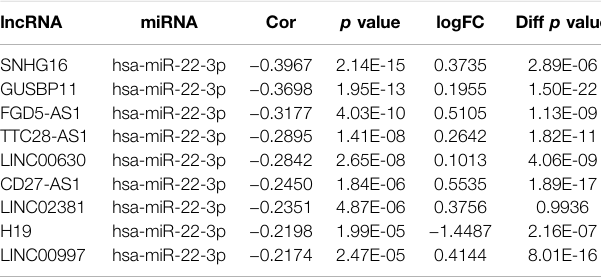
TABLE 3 | lncRNAs are signi fi cantly negatively correlated with miR-22-3p in LIHC and their expression in LIHC and control tissues. lncRNA